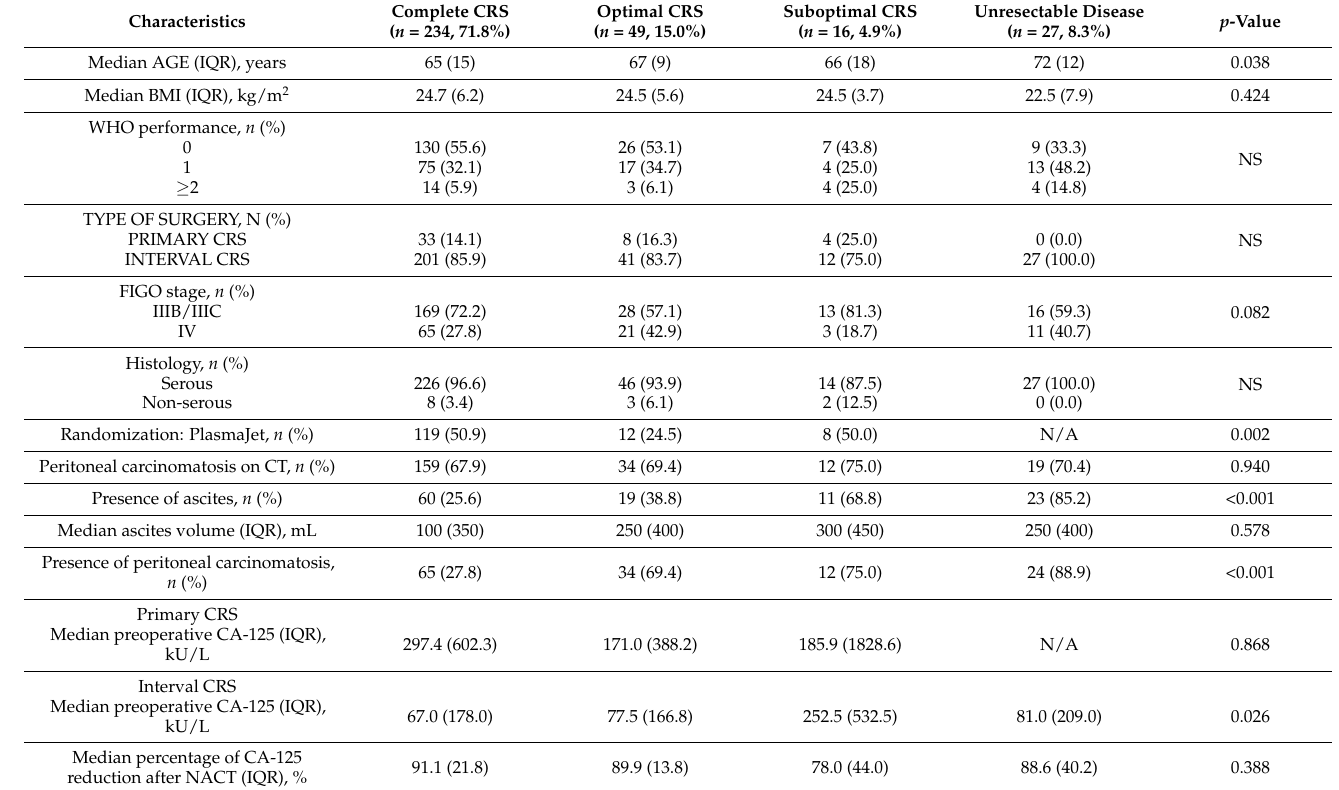
Table 2. Patients’ characteristics ( N =